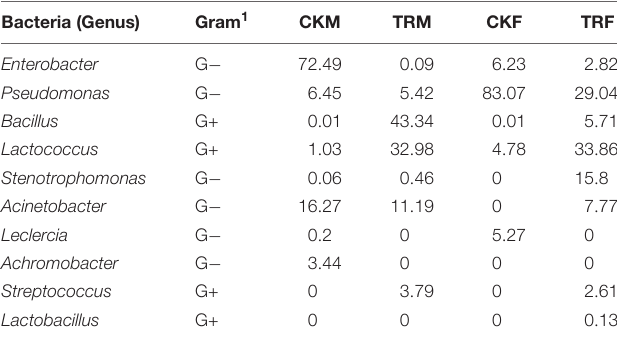
TABLE 1 | Top 10 bacterial genera in the Bactrocera dorsalis control and antibiotic treatment groups. Bacteria